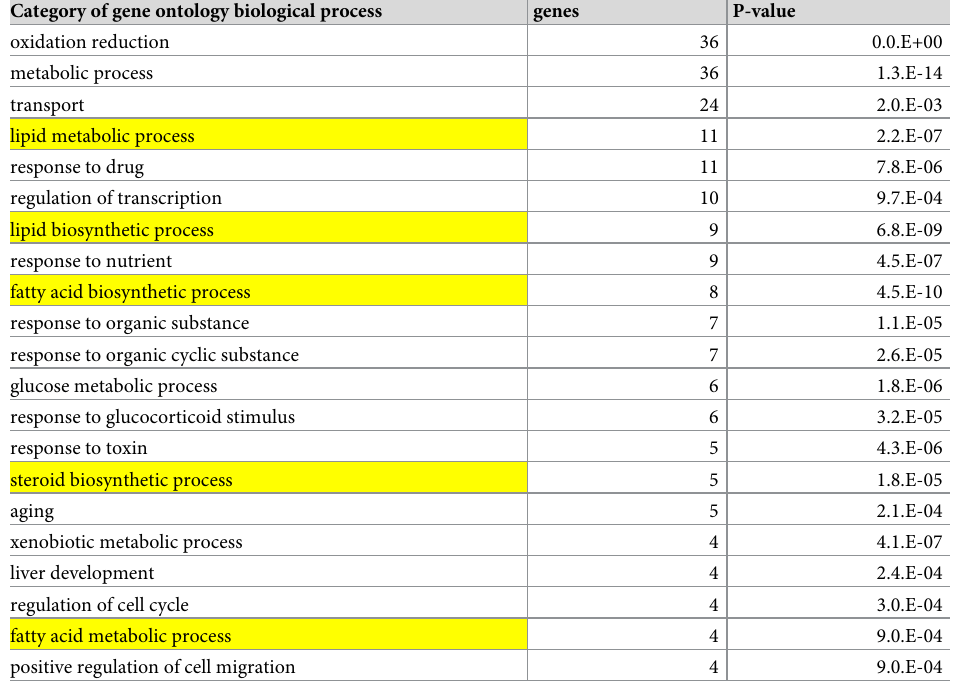
Table 1. Over-represented gene ontology involving hepatic genes expressed differently among groups